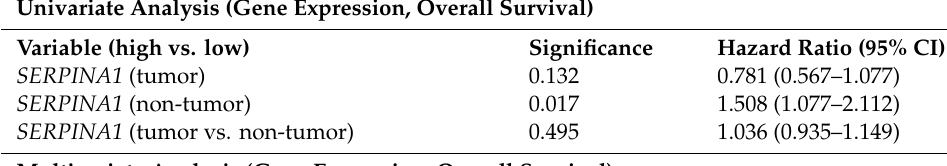
Table 2. Cox Regression